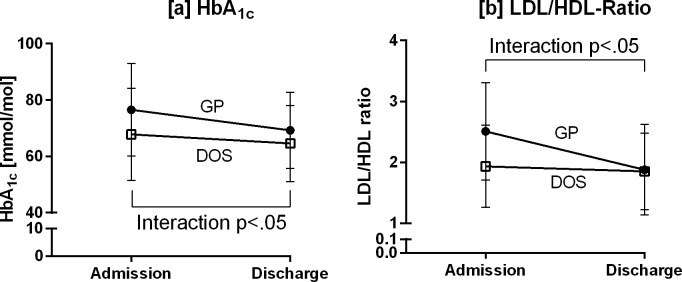
Improvement in HbA1c and LDL/HDL ratio in T1D patients attended at home either by general practitioners (GP, ●) or diabetes outpatient service (DOS, □).Means ± SD.